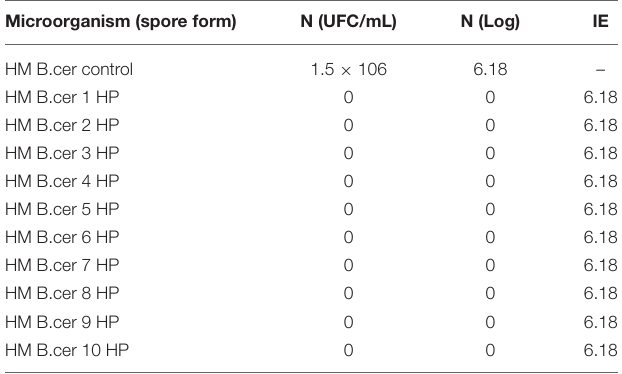
TABLE 2 | The effect of High Hydrostatic Pressure (HHP) on 10 samples of (1.5 × 106) colonies of Bacillus cereus ; HHP destroyed all the colonies, i.e., 1.5 × 106 colonies with Inactivation Efficiency (IE) = 6.18 Log.